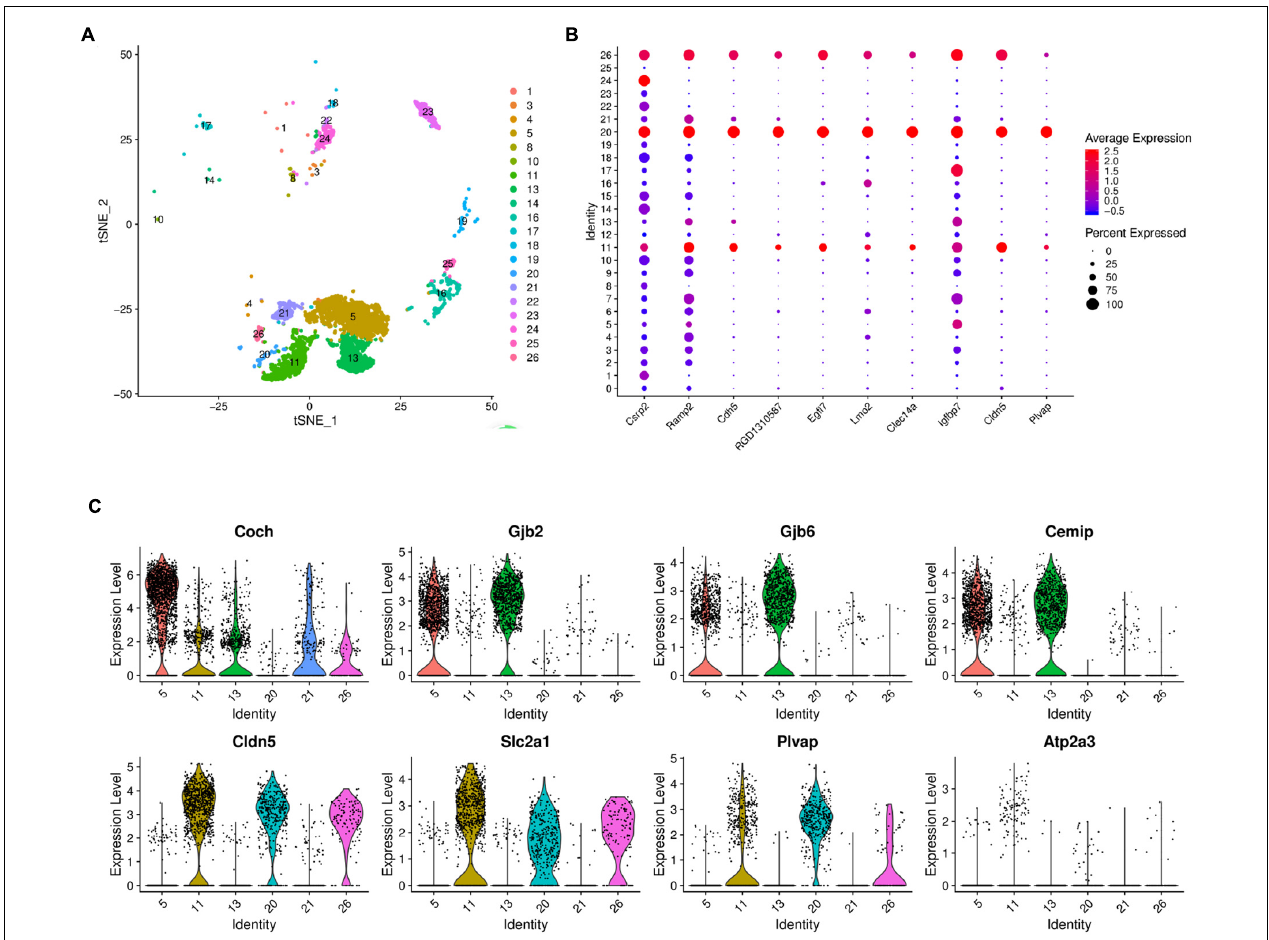
FIGURE 5 | Gene expression in inner cell clusters. (A) The t-SEN plots of clusters 11, 20, and 26 were closely linked to clusters 5, 13, and 21 in terms of spatial structure. (B) Dot plots representing gene expression levels of different cell clusters. Each dot was sized to represent the proportion of cells of each type expressing the marker gene and colored to represent the mean expression of each marker gene across all cell clusters. (C) Violin plots showing select genes that are deferentially expressed in the clusters of 11, 20, 26, and clusters 5, 13, and 21. Y-axis, log-normalized transcript counts.